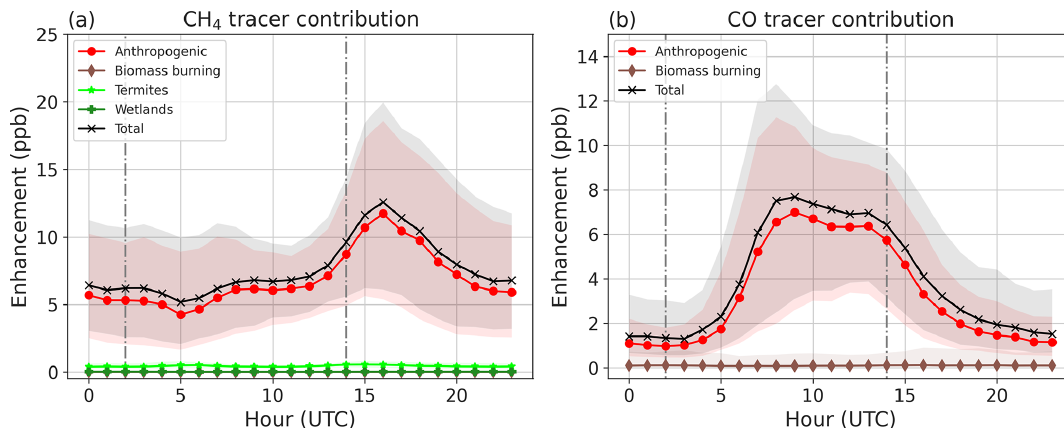
Figure 15. Diurnal cycle of tracer contributions for (a) CH 4 and (b) CO in situ surface concentration at